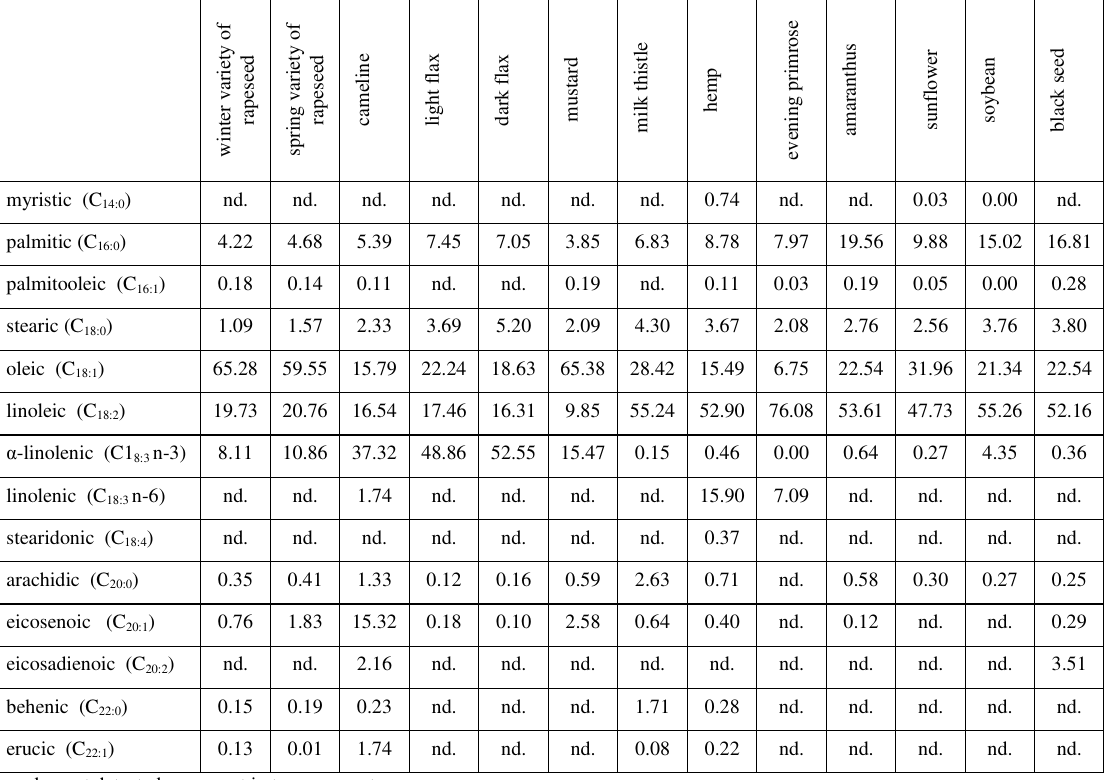
Table 1. The composition of fatty acids of analyzed vegetable oil